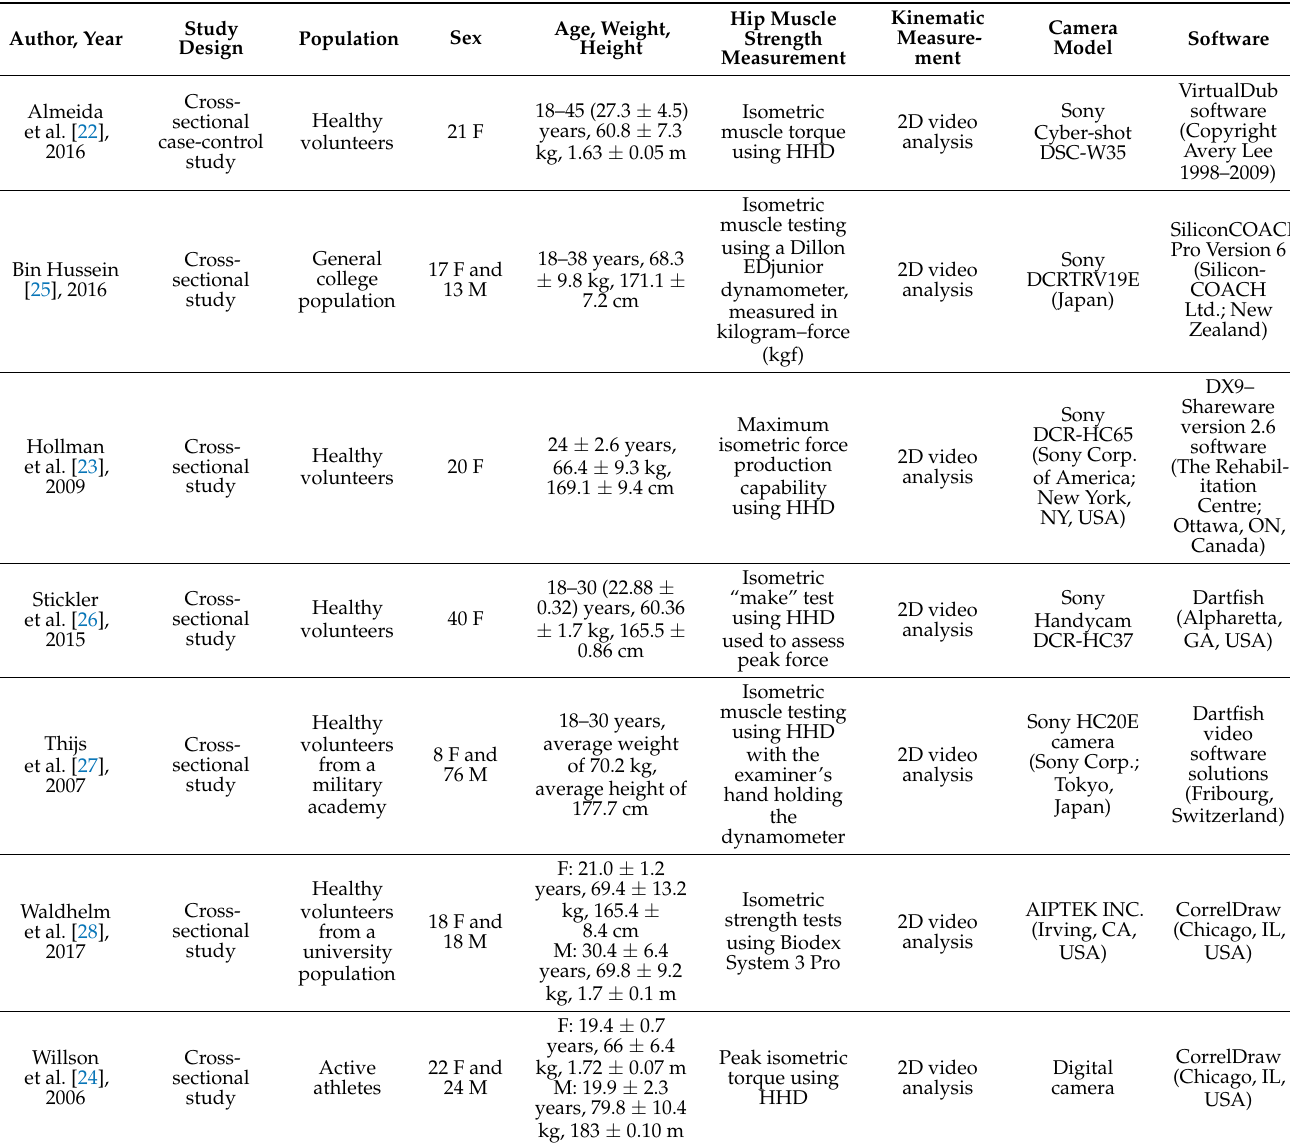
Table 2. The main characteristics of the included